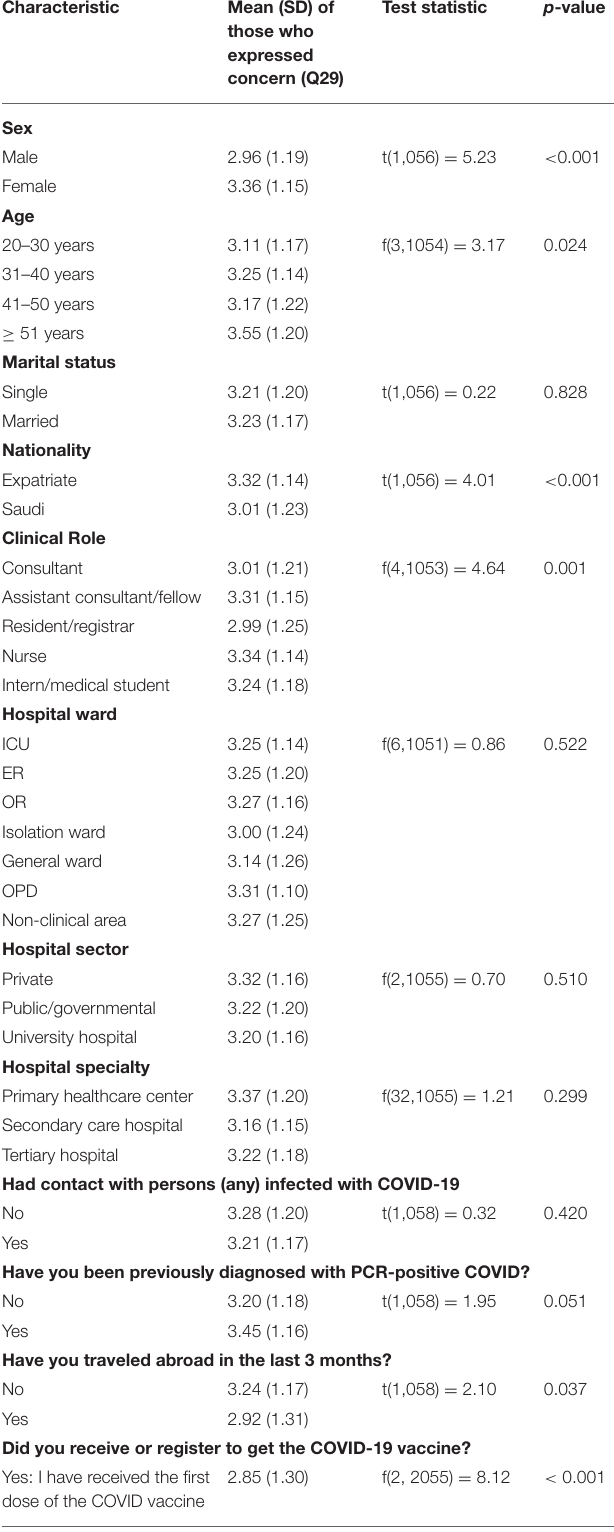
TABLE 4 | Bivariate analysis of HCWs’ characteristics and perceived worry regarding traveling abroad due to the emergence of the mutant COVID-19 strain ( N =